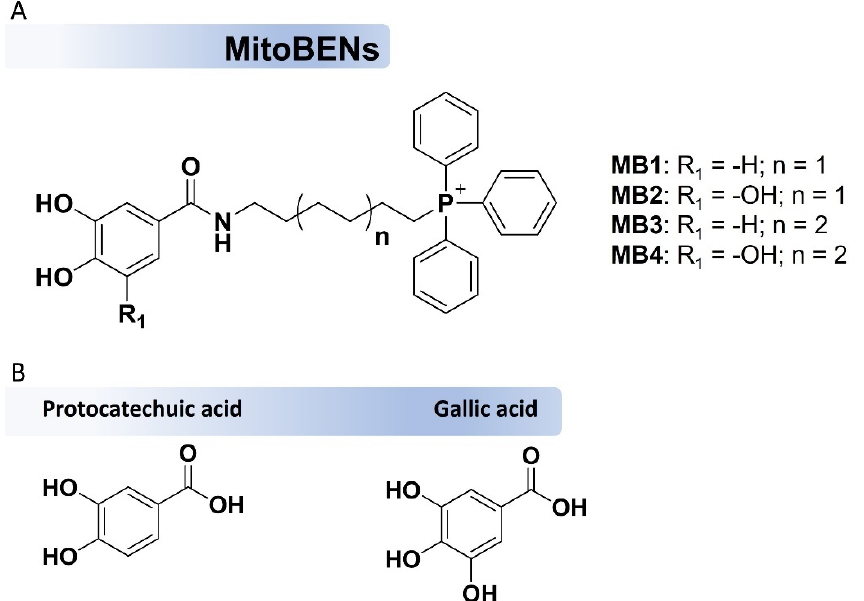
Figure 1. Chemical structures of hydroxybenzoic-based mitochondriotropic antioxidants MB1-MB4 (A) and the natural antioxidants protocatechuic and gallic acids (B).